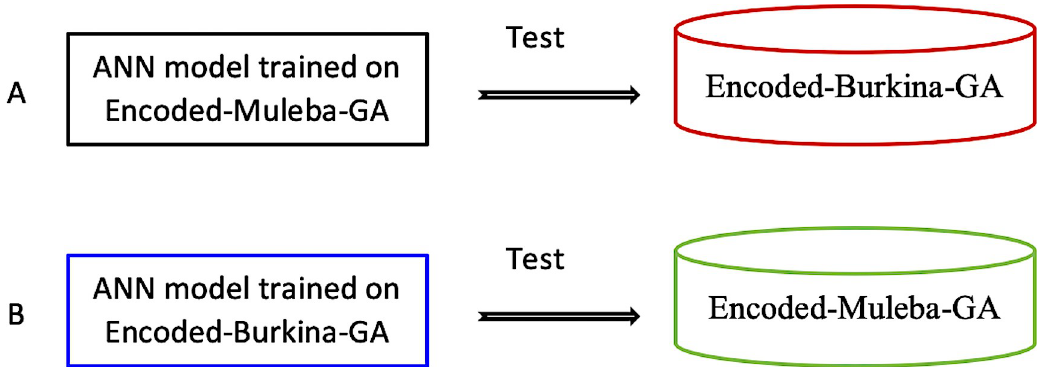
Fig 6. Independent testing of ANN model trained on encoded datasets. A) Applying an ANN model trained on the Encoded- Muleba-GA dataset to estimate the parity status of mosquitoes in the autoencoded Burkina-GA dataset. B) Applying the ANN model trained on the Encoded-Burkina-GA dataset to estimate the parity status of mosquitoes in the Encoded-Muleba-GA dataset.